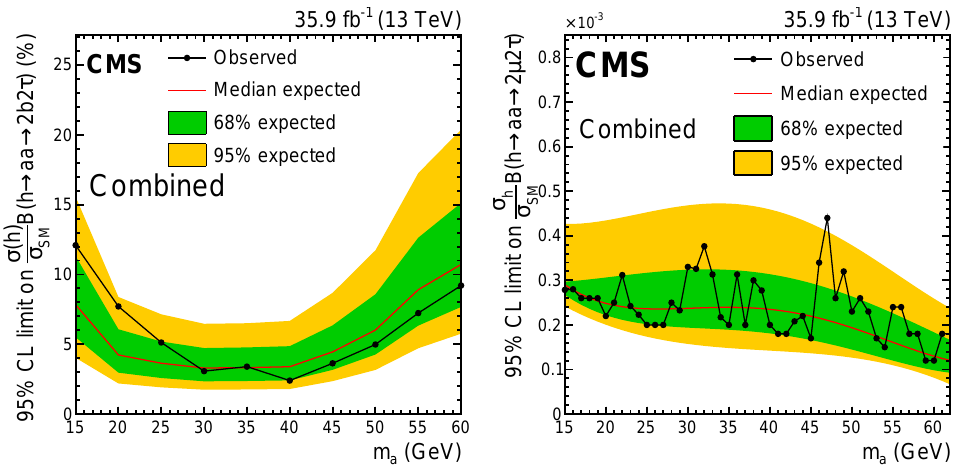
) × B ( h → aa → bb ττ ) and Figure 8: Upper limits at 95% CL on (left) ( σ ( h ) /σ SM ) × B ( h → aa → µµττ ) where the h → aa → 4 τ process is on (right) ( σ ( h ) /σ SM considered as a part of the signal, and is scaled with respect to the h → aa → µµττ signal. [ 20,21